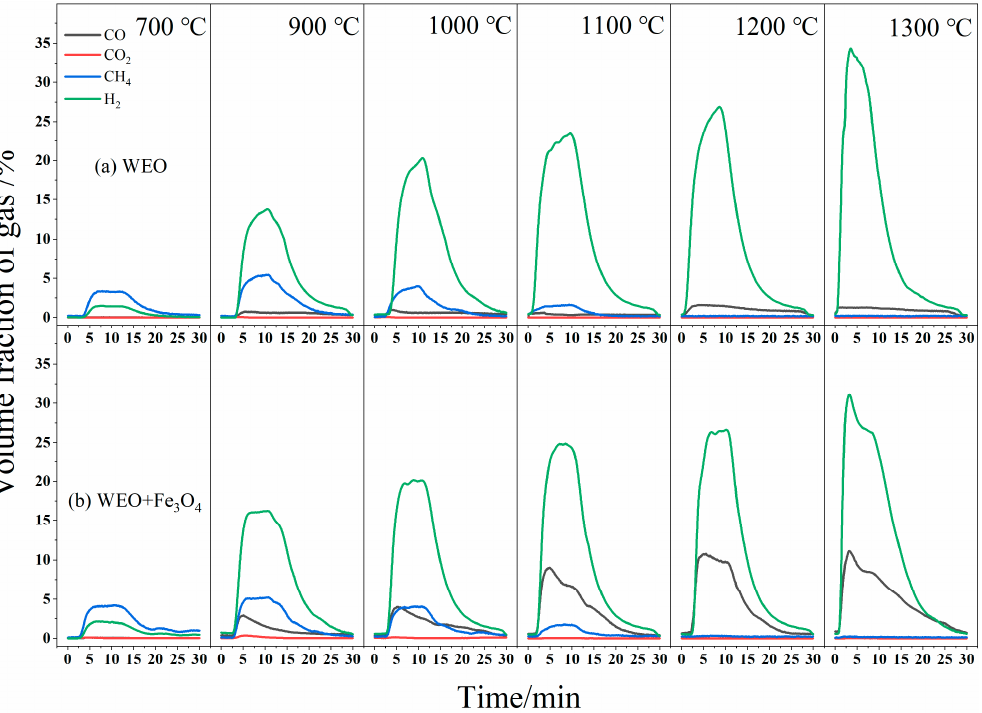
Figure 7. The volume fraction of produced gas as a function of time, ( a ) WEO cracking directly; ( b ) WEO cracking with 1.5 g Fe 3 O 4 .